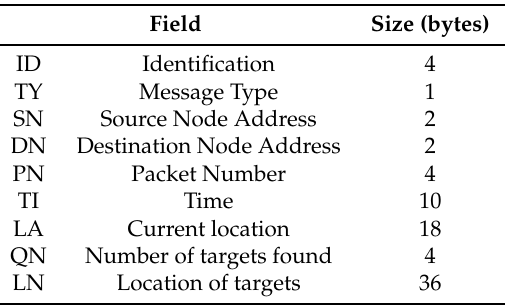
Table 2. Control message (CtrM)